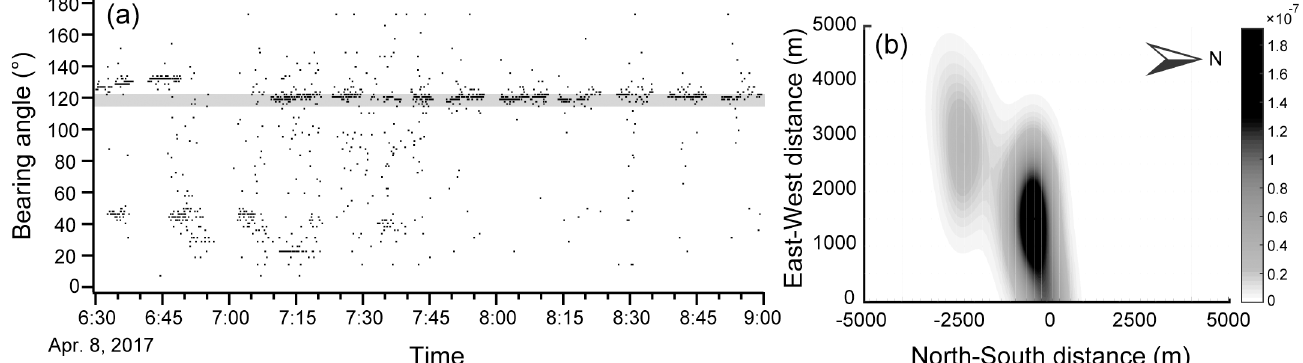
Fig 4. Estimated location of singers from 7:30 to 8:00 am. Black circles show each singer’s location calculated acoustically in 35 analyzed days. The ship trajectory (black line) on February 20 was drawn in both maps with or without the ship operating.